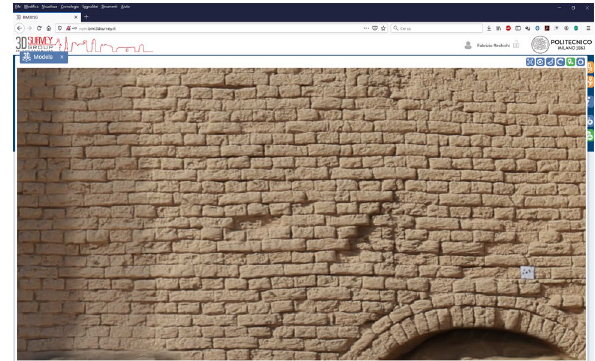
Figure 3 – A detail of a high quality multi textures; Fort of Umm al-Dabadib, shown in Figure 7, with 25 textures of 4.096x4.096 each, thus 419,43Gpixel on a model with 6,8 millions of triangles.